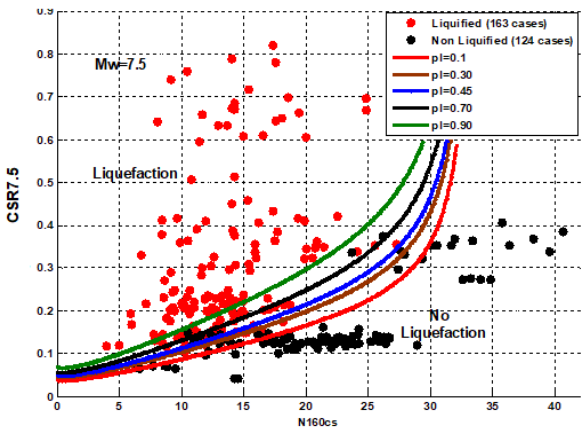
Figure 2: Bayesian mapping function along the case history databaseusing the original version of the simplified procedure. CSR = cyclic stress